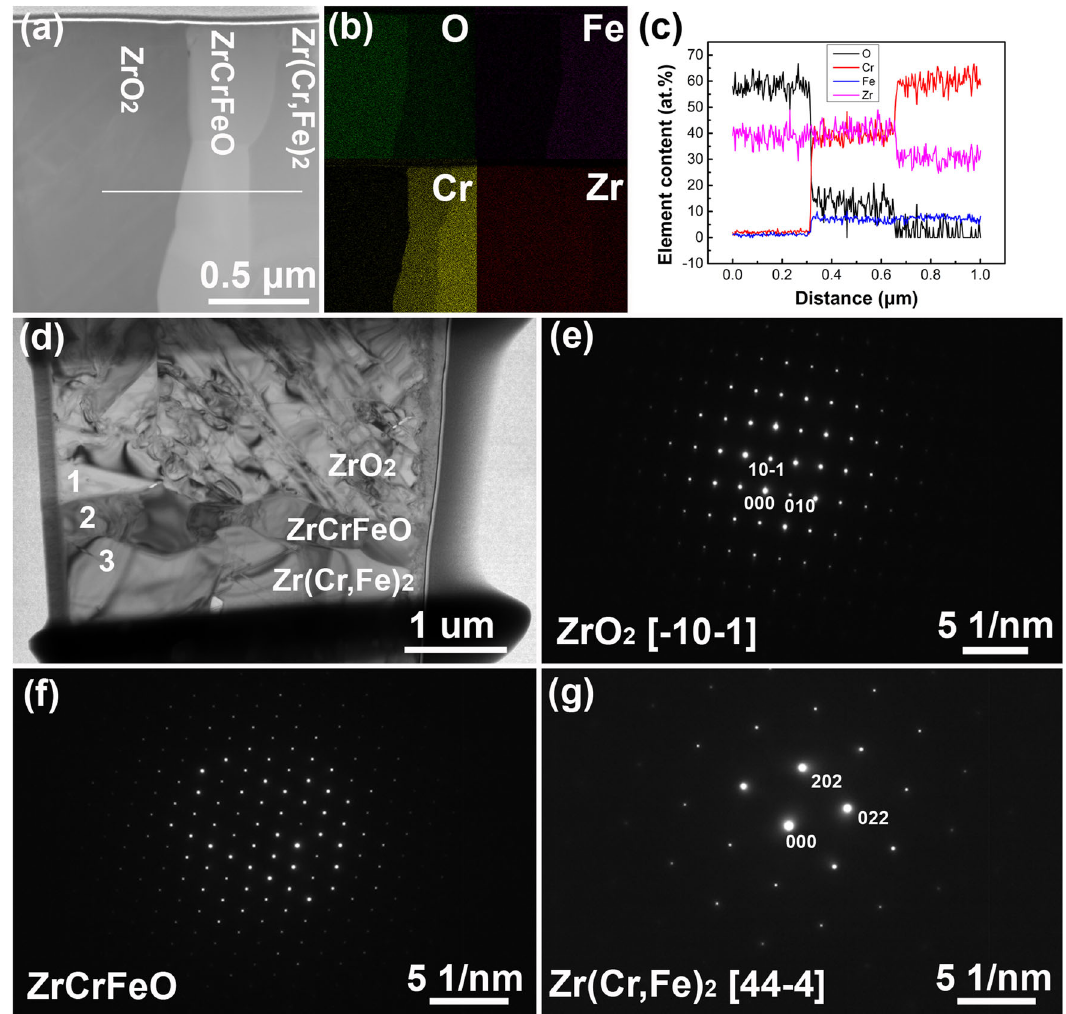
Fig. 7 Microstructures and compositions at the interface of layers 6/7 in Fig. 4. a HAADF and d TEM images of ZrO 2 , ZrCrFeO, and Zr(Cr,Fe) 2 , and corresponding b EDS mappings and c EDS line scan; SEAD patterns of e ZrO 2 , f ZrCrFeO, and g Zr(Cr,Fe) 2